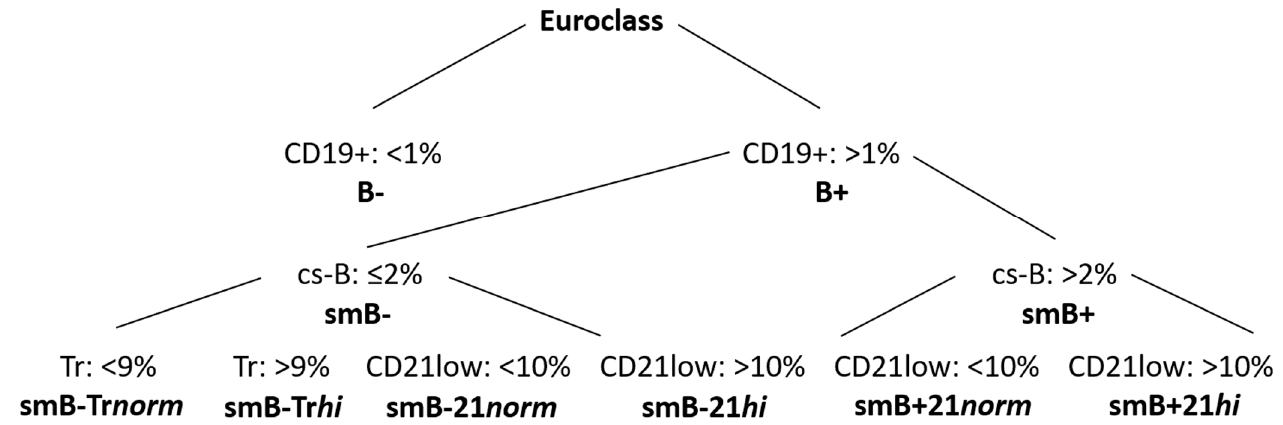
Figure 2. Euroclass classification of Common variable immunodeficiency (B, B cells; cs/sm, class- switched/switched-memory B cells; Tr, transitional B cells; norm, normal count; hi, high count)